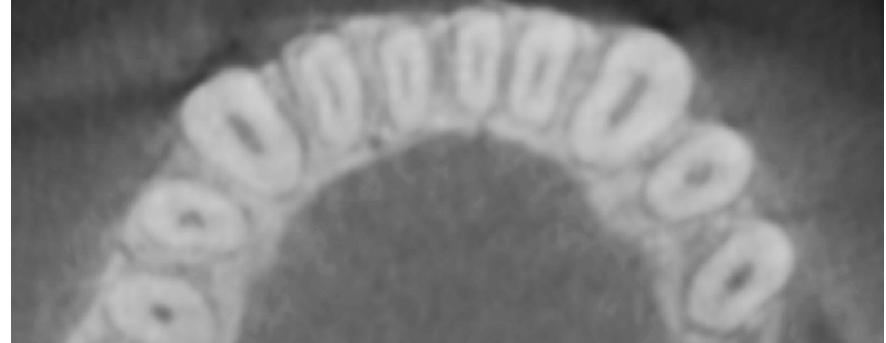
Figure 1. Cone Beam Computed Tomography (CBCT) image of modified piezocision corticotomy between 4-2 and 4-3.